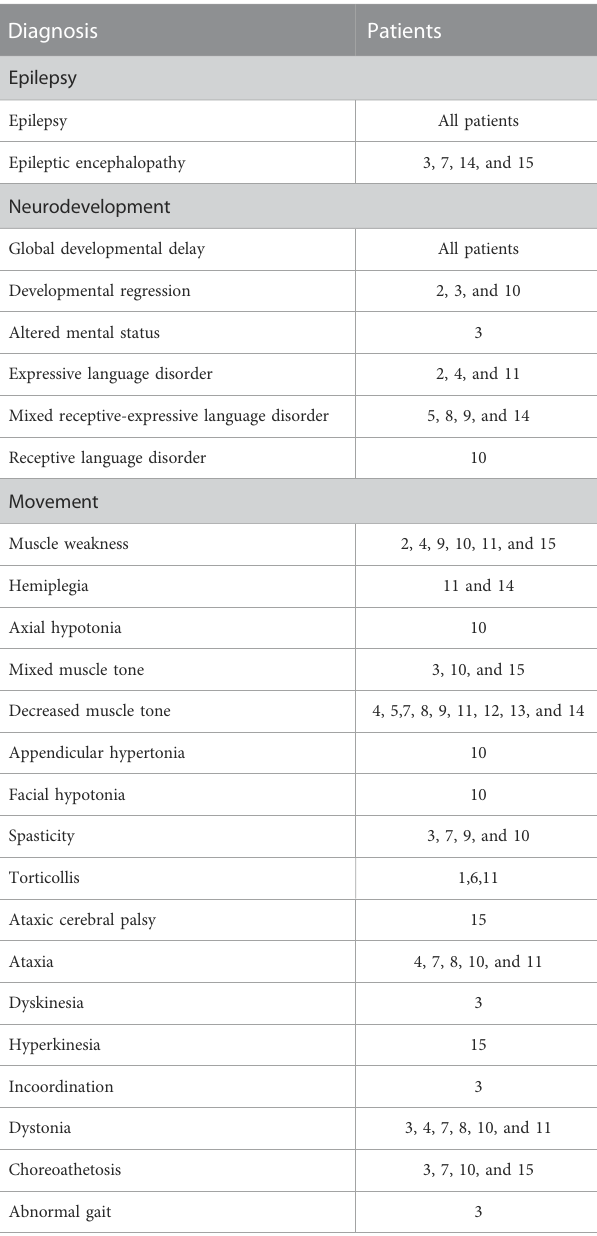
TABLE 3 Clinical diagnosis summary. Clinical diagnoses extracted from the medical records were subdivided into three categories: epilepsy, neurodevelopmental delay, and